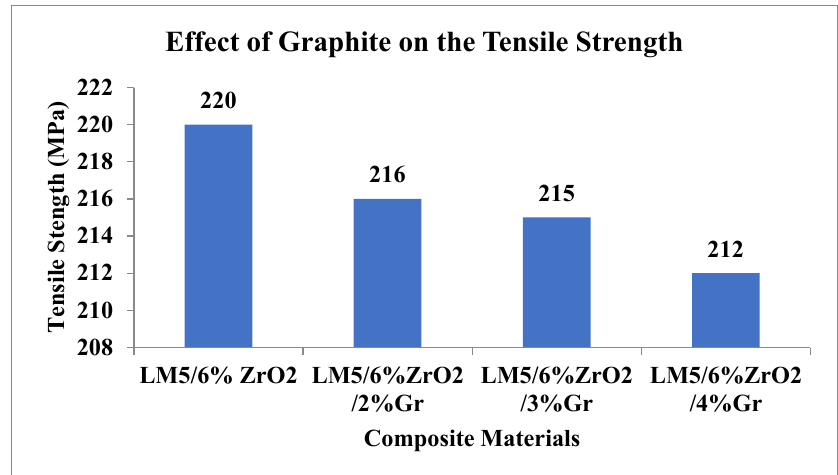
Figure 13. Fractured tensile test specimens.